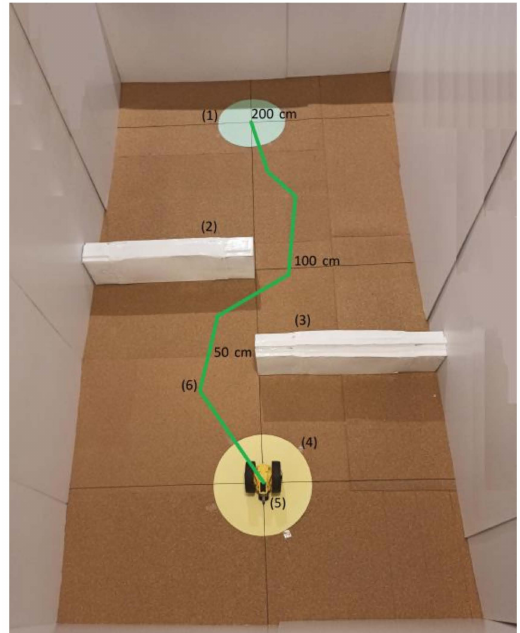
Figure 19. Trajectory in a labyrinth with two obstacles: (1) goal, (2,3) obstacles, (4) home, (5) robot, and (6)